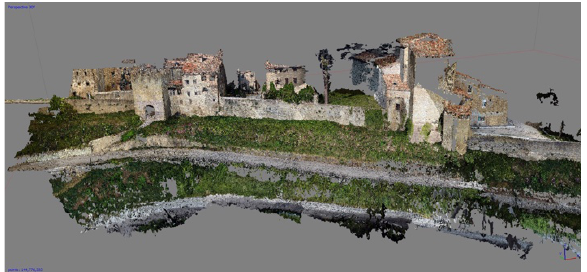
Figure 3. Dense cloud of the selected city walls portion elaborated with Agisoft Metashape software (© authors).